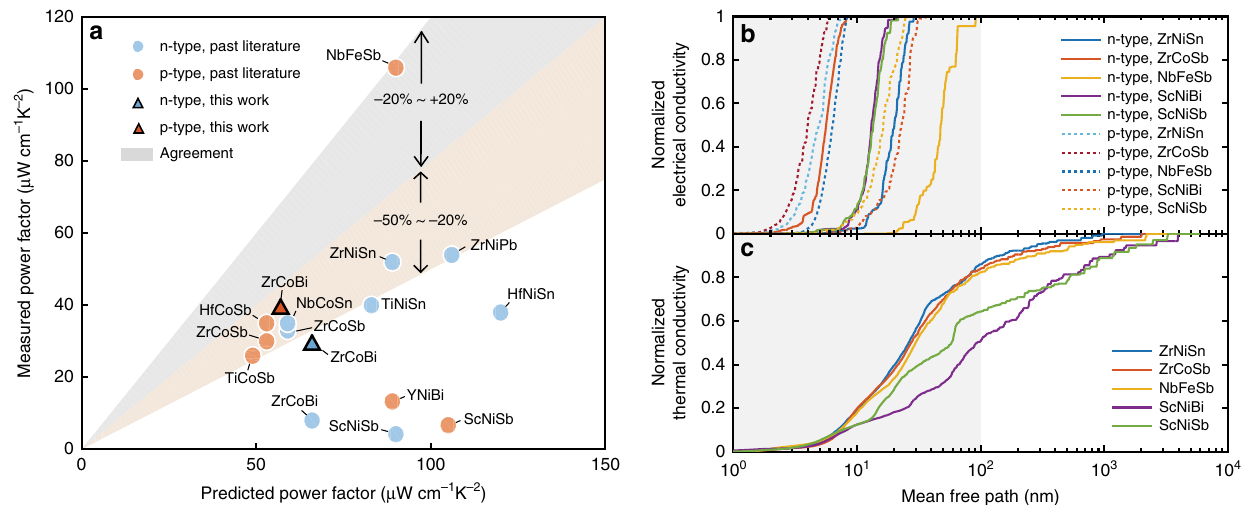
Fig. 4 Evaluation of thermoelectric performance. a Power factors compared with experiments for various half-Heusler compounds. Only compositions with experimental values are shown here (not including alloys). The maximum power factors from experiments are taken to compare with the calculation (see more discussion on the temperature dependence in Supplementary Note 1, and the presented power factor values in Supplementary Tables 5 and 6). b The accumulated electrical conductivity with respect to the electron mean free path for both n- and p-type. c The accumulated thermal conductivity with respect to the phonon mean free path. The results are shown for materials with corresponding doping types that exhibit high-power factors according to Fig. 3c. The shaded area (<30 nm) denotes the MFP range where electrons mostly dominate the electrical transport but phonons contribute negligibly to the thermal